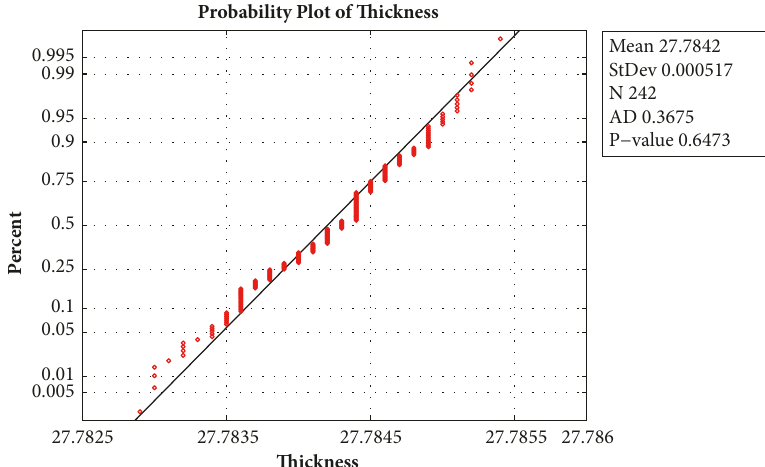
Figure 5: The normal probability plot of the 242 observations.